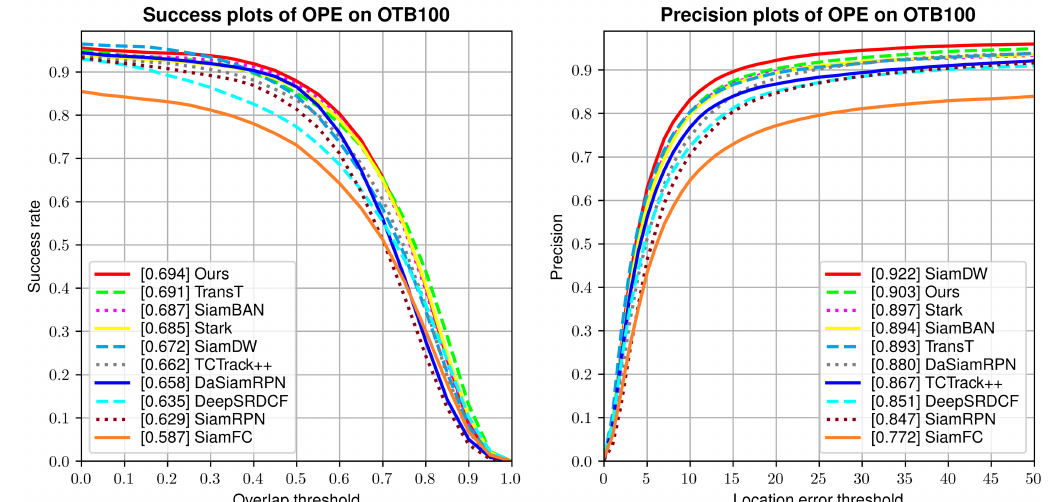
Figure 5. Tracking results on OTB-2015.